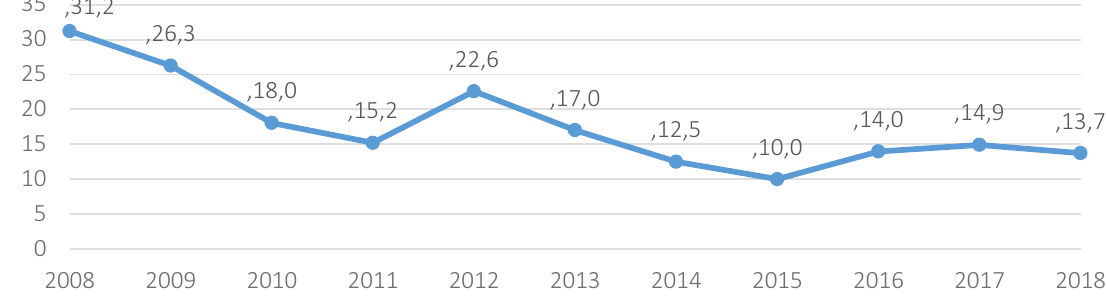
Figure 4. Capital investment in Odesa region in 2008–2018, interest rate to GRP